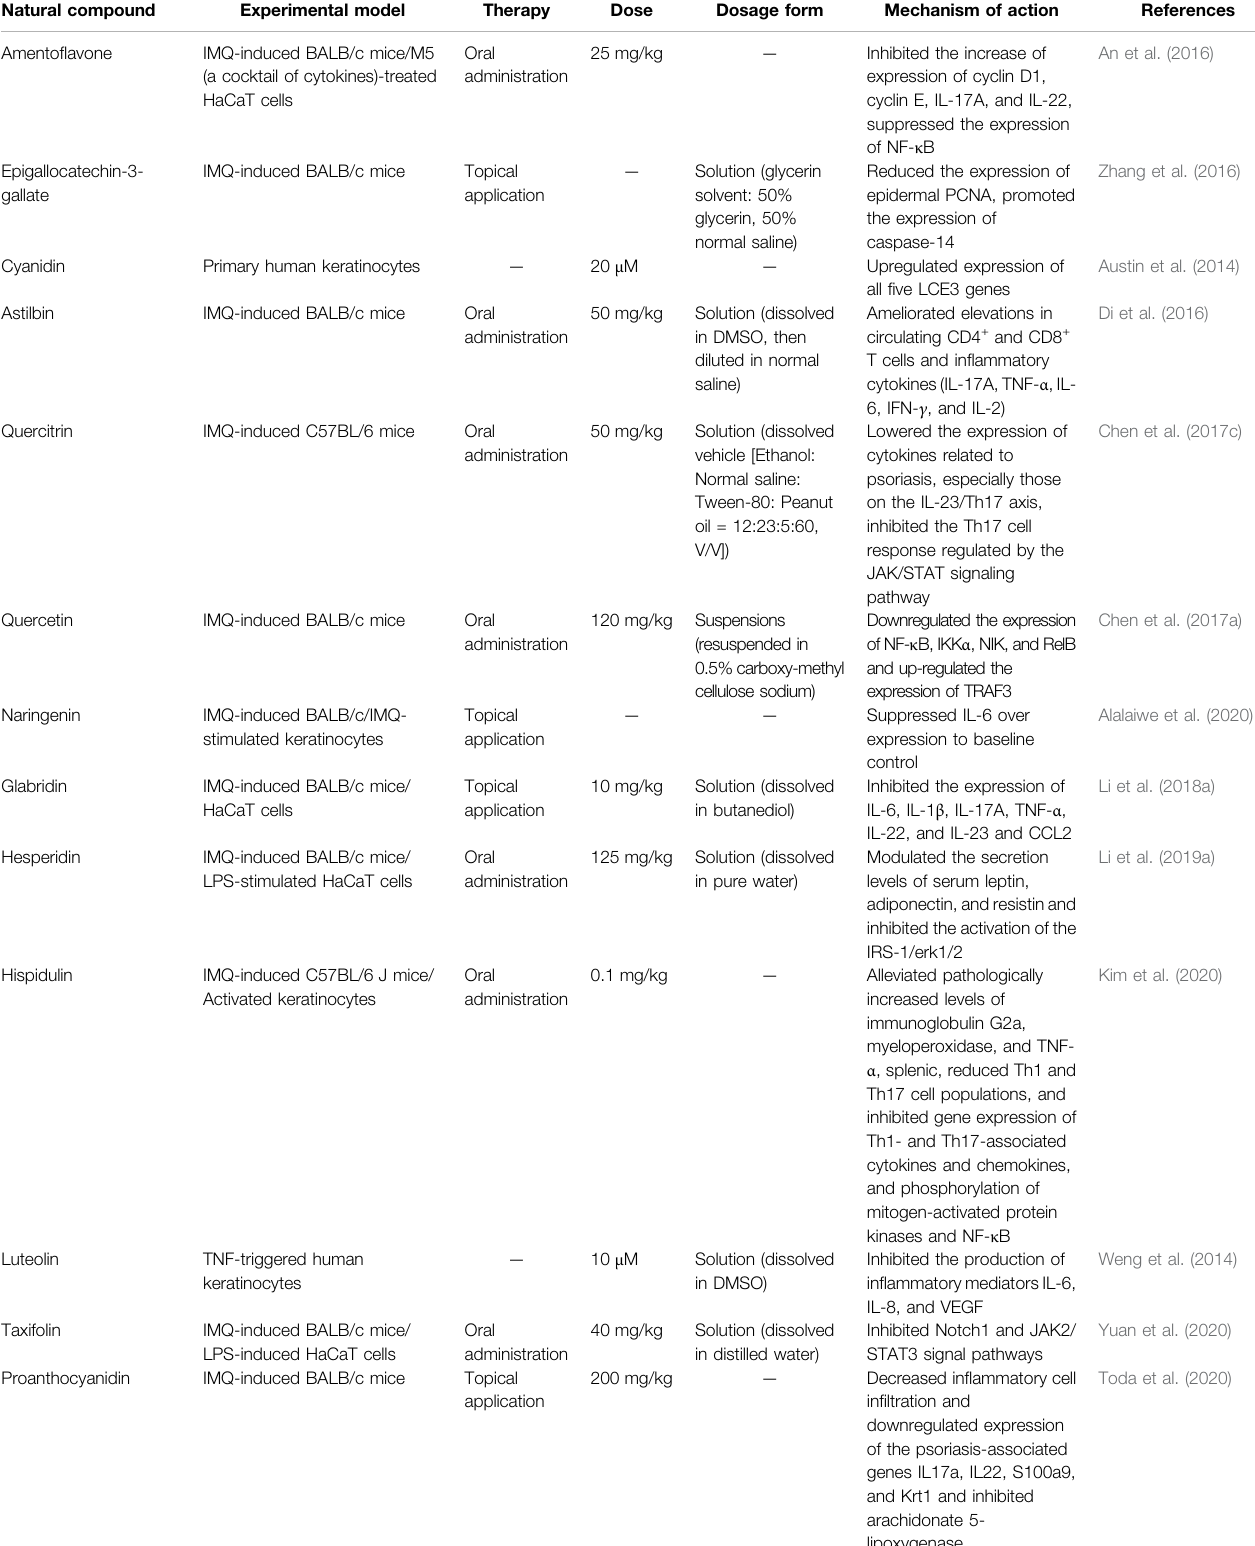
TABLE 1 | Flavonoids for the treatment of